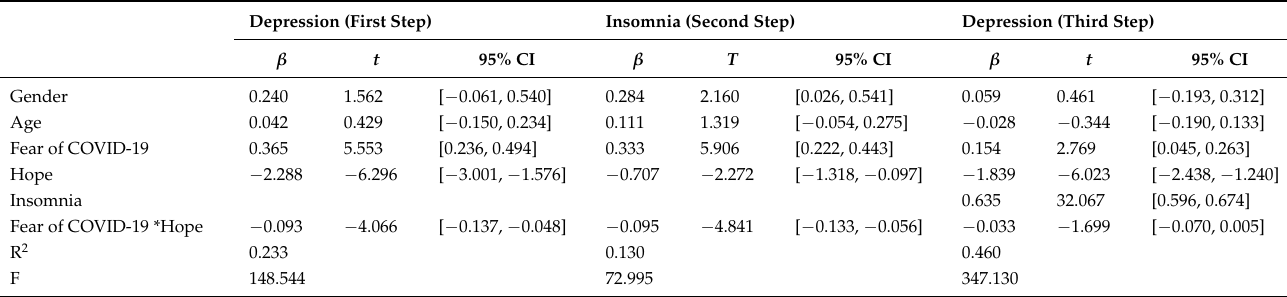
Table 3. The results of mediated moderation model test.